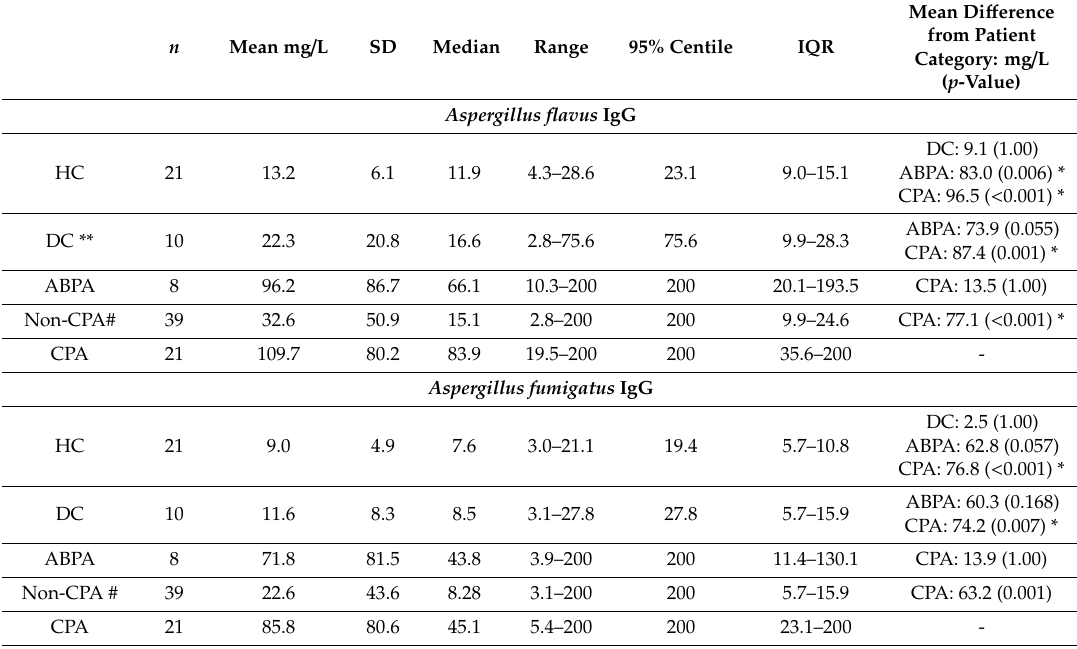
Table 2. Antibody testing results with both antigens against di ff erent